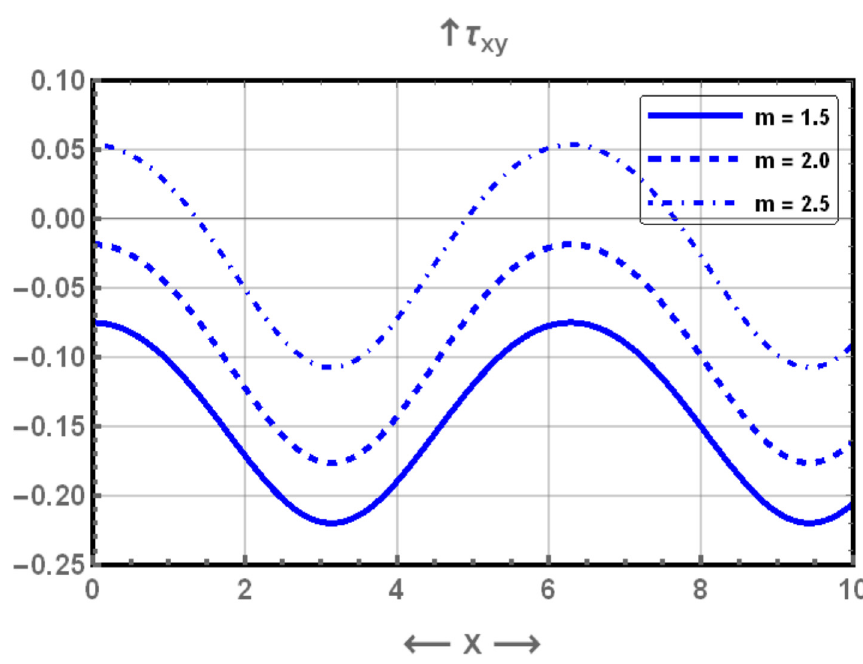
Figure 4. Display of shear stress profile for different values of Gr .